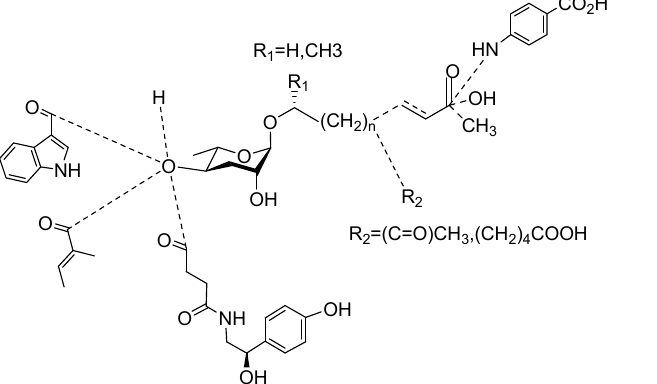
Figure 4. Overview of the chemical structures of pheromones with other functions secreted by nematodes. Table 1. Pheromones are secreted by nematodes.